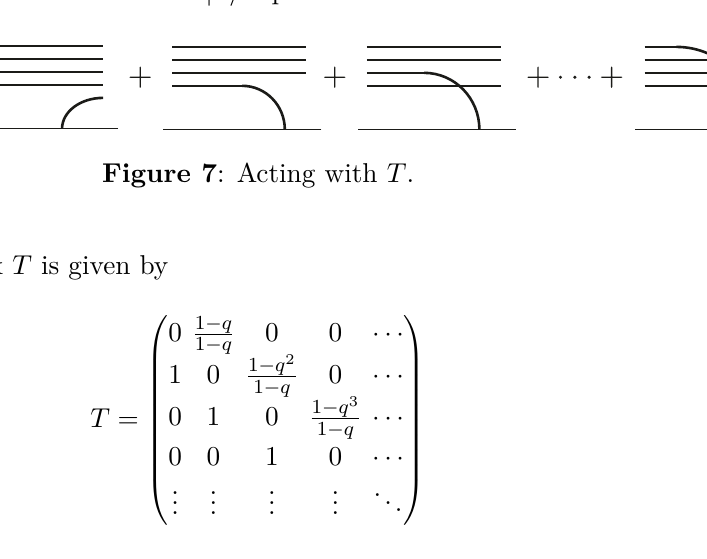
Figure 6 : The vector | n i represents n stacked chords.